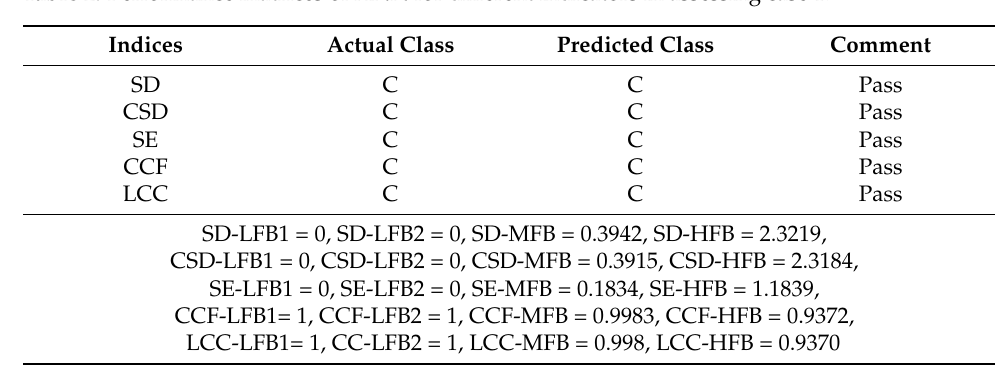
Figure 24. Axial collapse of LV winding due to clamping failure [24]. Table 2. Performance matrices of ANN for different indicators in assessing case